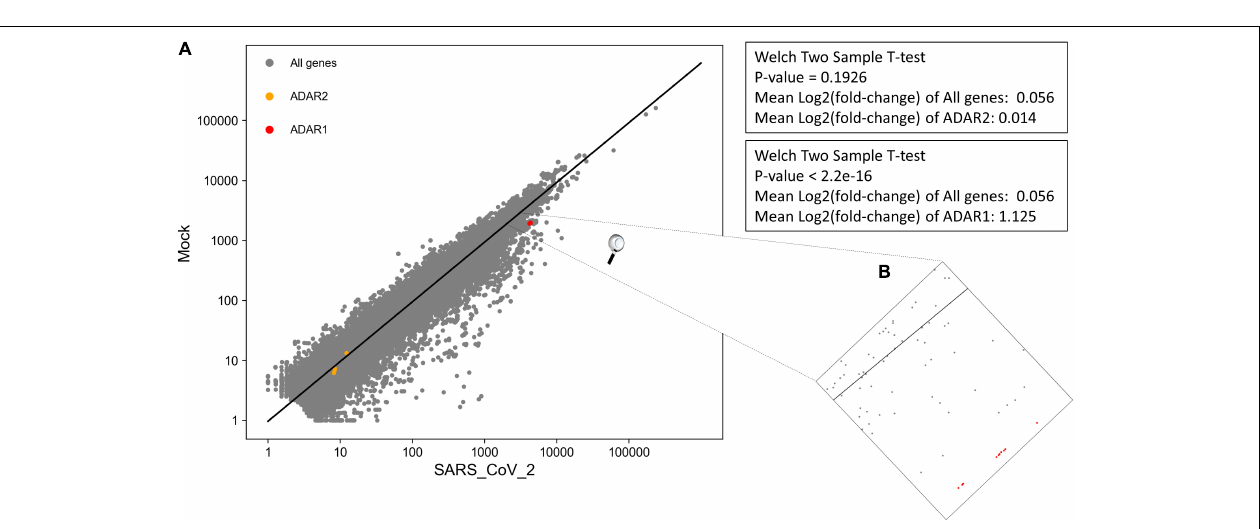
FIGURE 4 | Significant upregulation of ADAR1 isoforms, but not ADAR2, in cells infected with SARS-CoV-2 virus, compared to mock. (A) Log scale plot shows normalized gene counts from mock cells against cells infected by SARS-CoV-2 virus. Every dot in the graph represents a gene: ADAR1 isoforms (red), ADAR2 isoforms (orange), and all other genes (gray). The black line is the regression line for all genes. The P -values were obtained using a Welch two-sample T -test on only transcripts with coefficient variation > 1. (B) Zoom in on ADAR1 isoforms on the log scale plot. All 10 isoforms are closely located on the